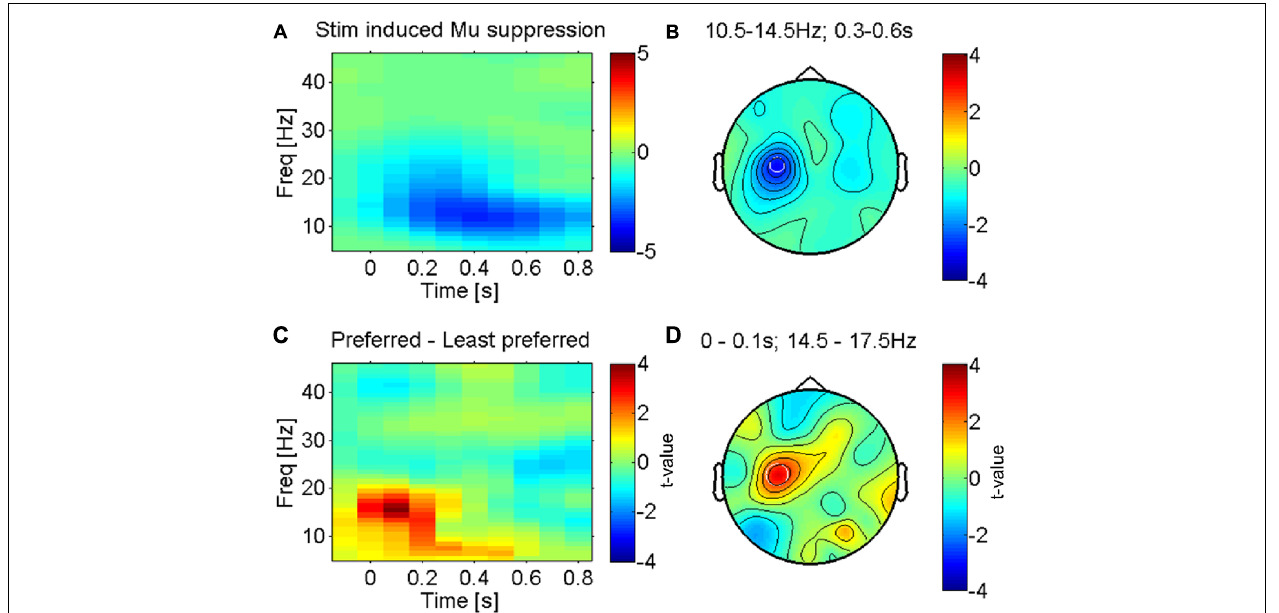
(electrode ‘C3’), contralateral to the side of stimulation (right forearm), as expected. (C) Time-frequency profile of the direct statistical comparison (dependent sample t -test) between oscillatory power in ‘C3’ for preferred and least preferred fabrics. A significant difference emerges just after stimulus onset in the higher mu-band (14.5–17.5 Hz). (D) Topography of this effect is consistent with the well-known mu-suppression (peak in ‘C3’) and therefore presumably the somatosensory cortex, see